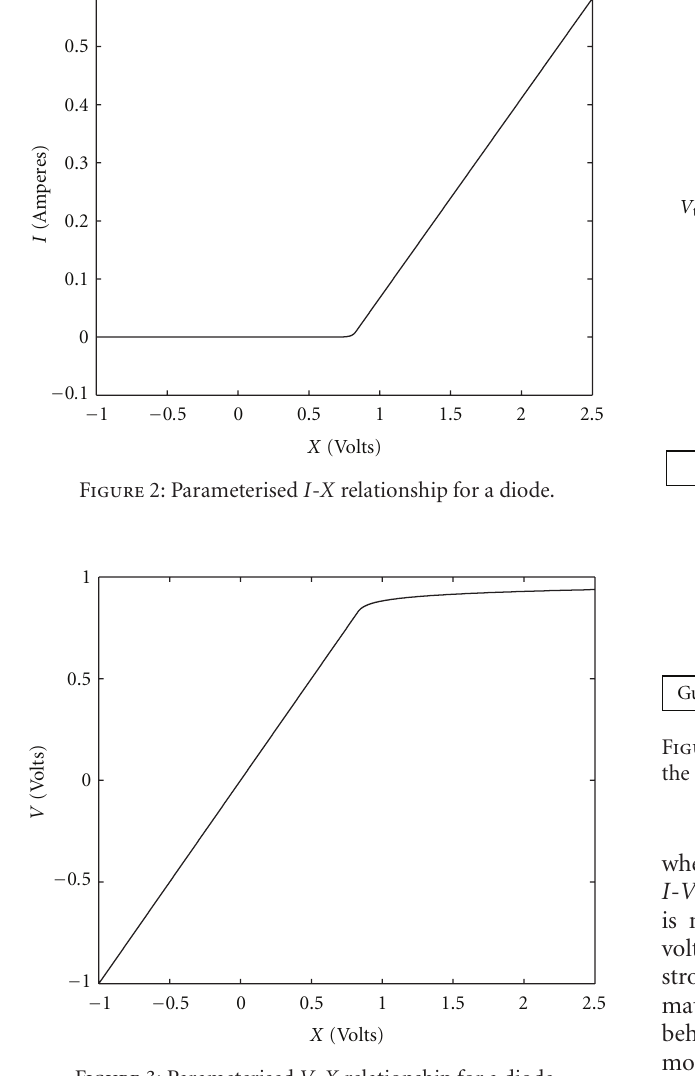
Figure 3: Parameterised V - X relationship for a diode.